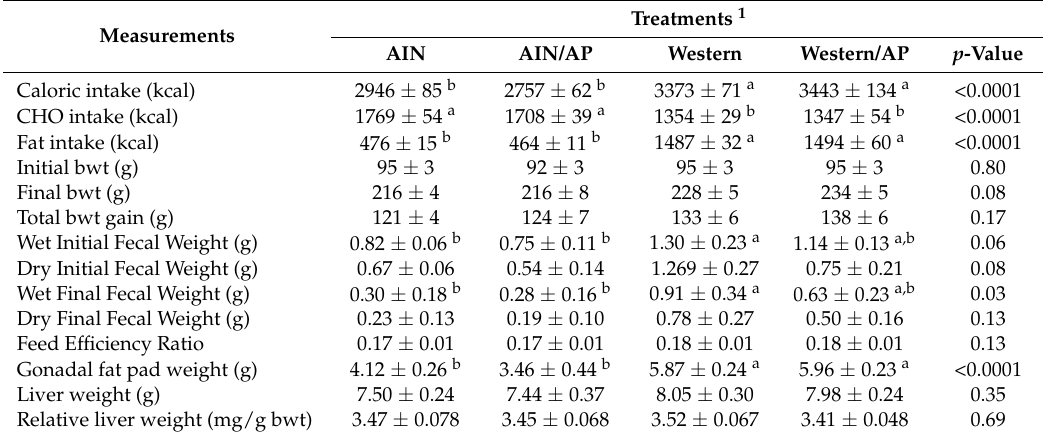
Figure 1. Growth curve of rats fed different diets containing apple pomace. Table 4. Effect of consumption of different diets substituted with apple pomace (10% g/kg) by growing female rats on caloric intake, body weight, and liver weight following eight weeks of feeding.